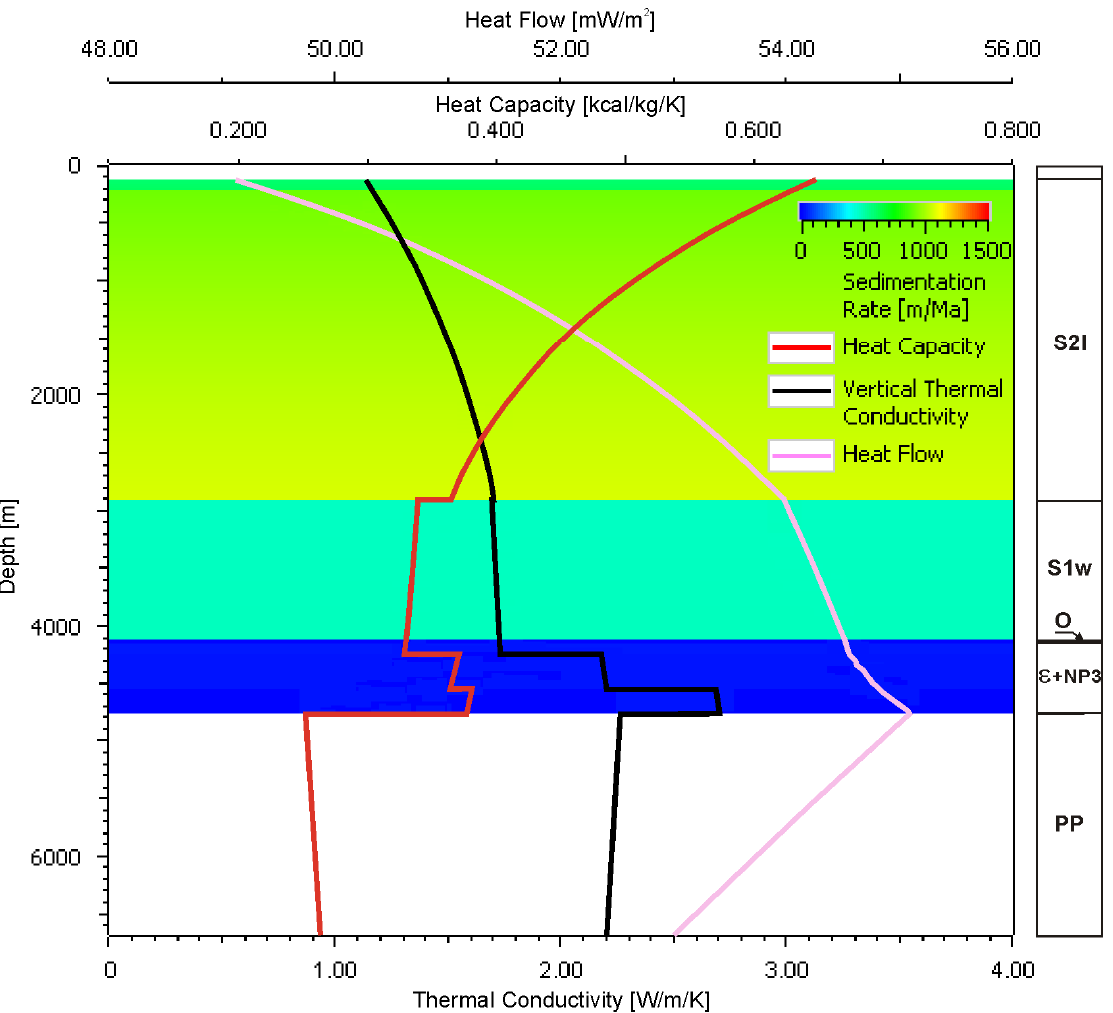
Figure 9. Blanketing effect after deposition of Lludlovian sediments.